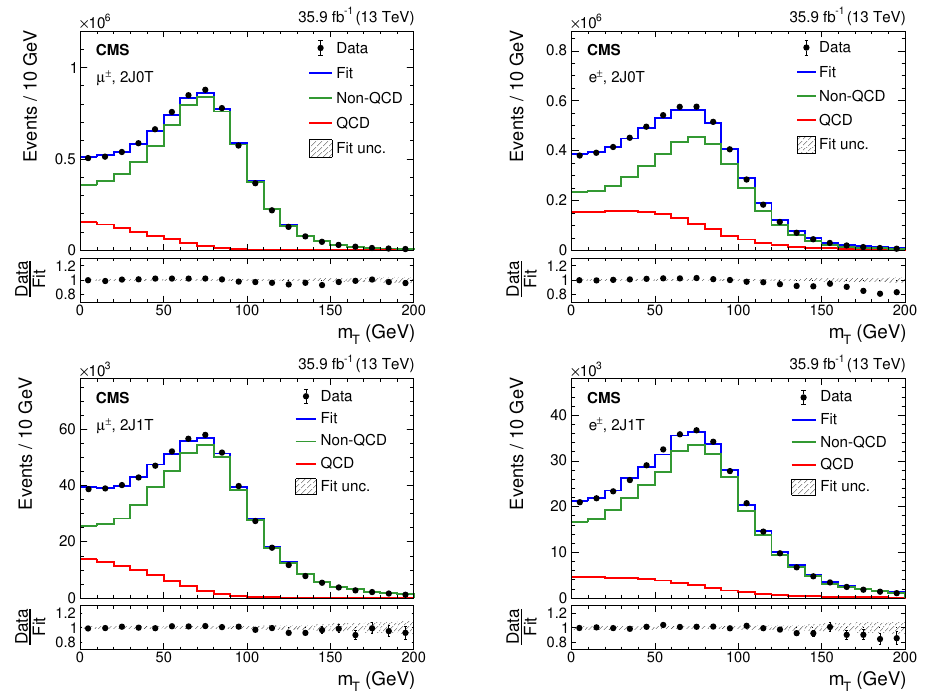
distributions for the muon (left) and electron T distribution predicted by the T